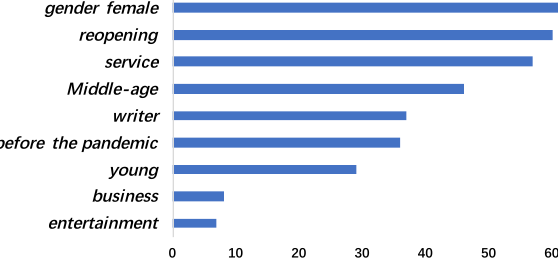
Figure 10. Feature importance ranking from